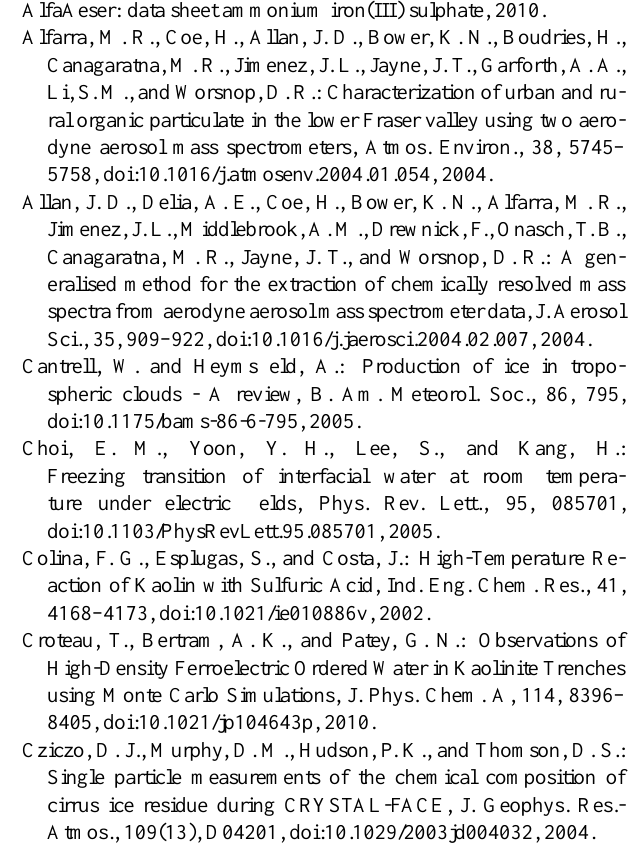
Fig. A3. Transmission correction for BCR and ATD particles. The figures show the projected transmission curves as calculated from the fits in Fig. A2 as well as the projected size distribution when the transmission of the aerodynamic lens is taken into account.